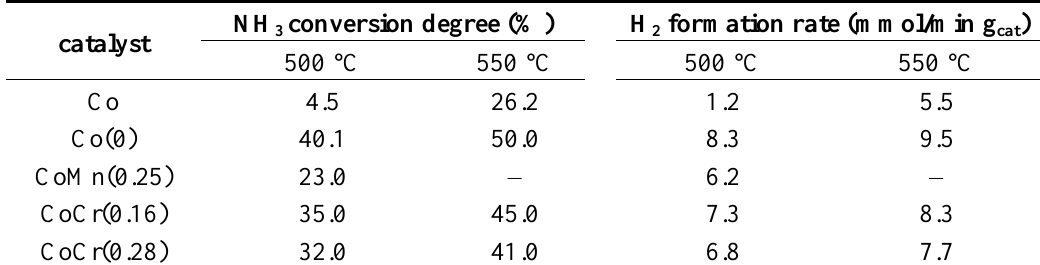
Table 2. NH conversion degree and H 3